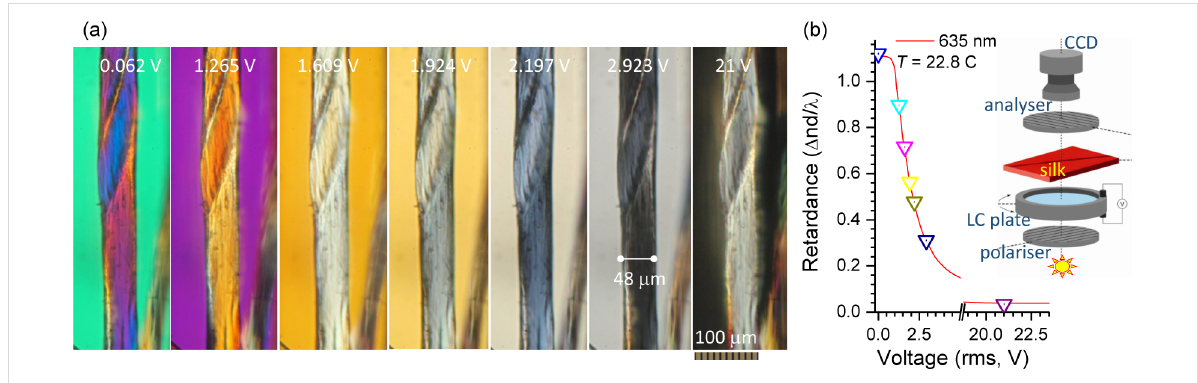
Figure 3: (a) A series of optical images taken at different voltages of a liquid crystal (LC) retarder (schematically shown in the inset of (b)) and a Nikon Optiphot-pol microscope with LMPlanFL 20× objective lens, NA = 0.4. (b) Calibration curve of retardance as a function of voltage collected at 635 nm wavelength and 22.8